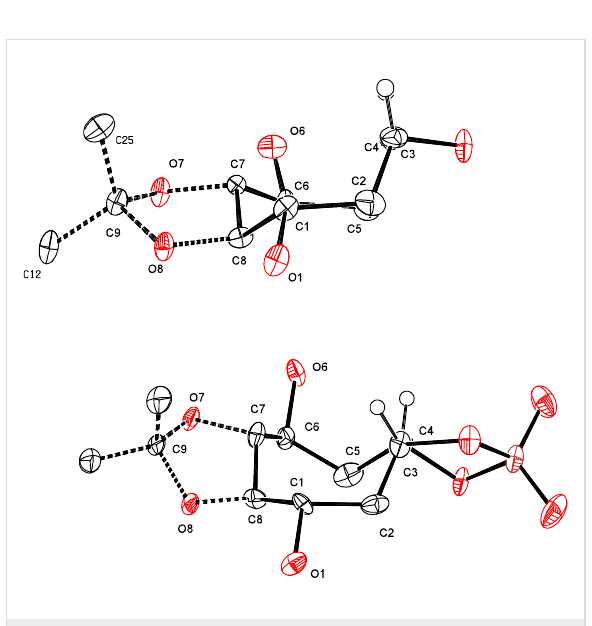
Figure 5: X-ray structure of epoxide 7 (upper) and sulfate 9 (down) solved using SHELXS and anisotropically refined using SHELXL programs